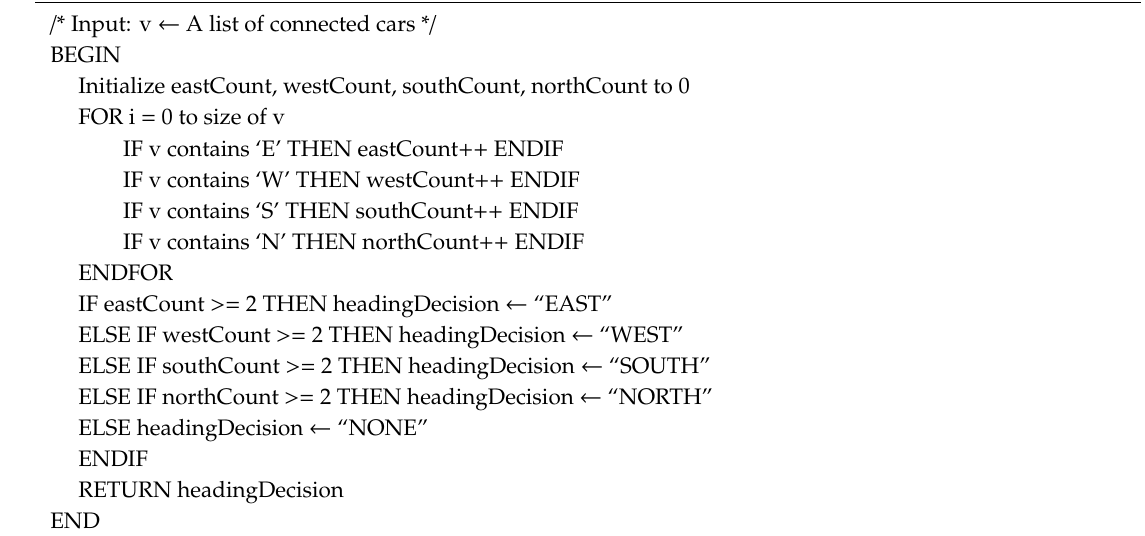
Algorithm 2 Determining the representative heading direction